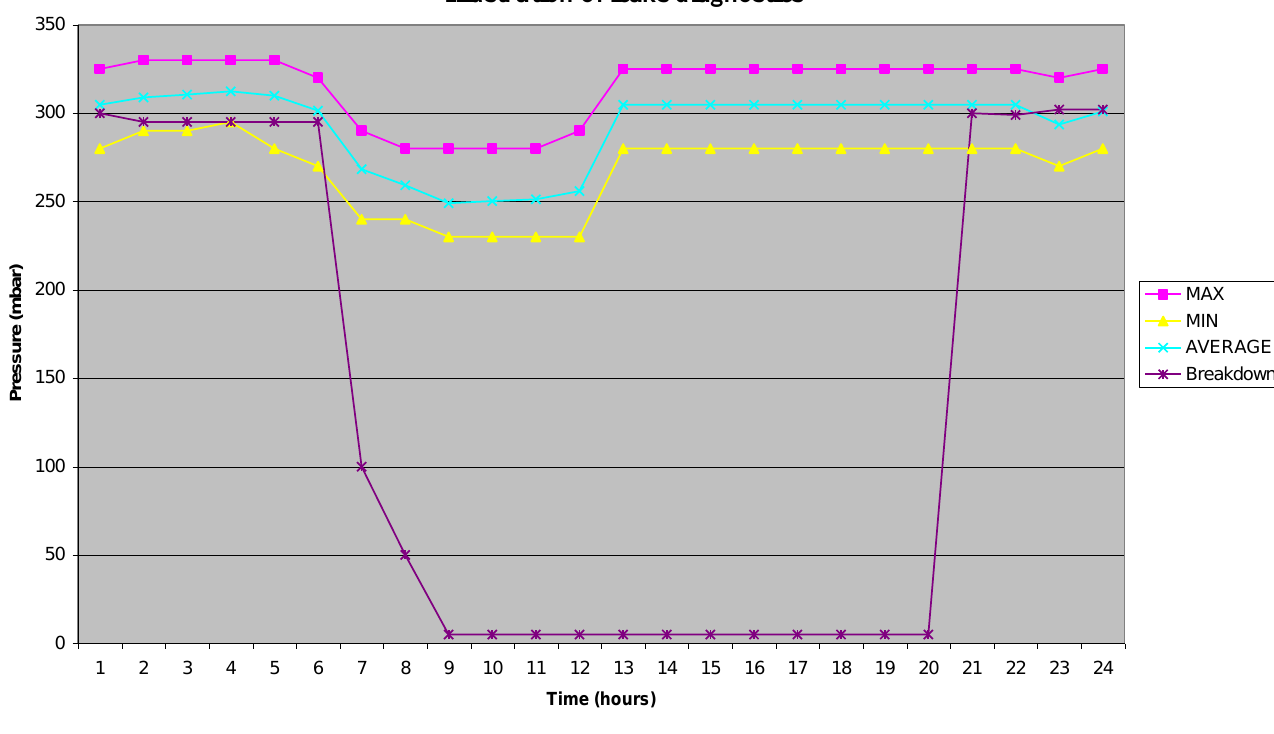
Figure 6. Algorithmic treatment of a leak. From 6 a.m. to 9 p.m. The BREAKDOWN curve is the evolution of Er( i,j ) data during the leaks, compared to Et( i,j ) data. ILLUSTRATION OF LEAKS Illustration of leaks diagnostics